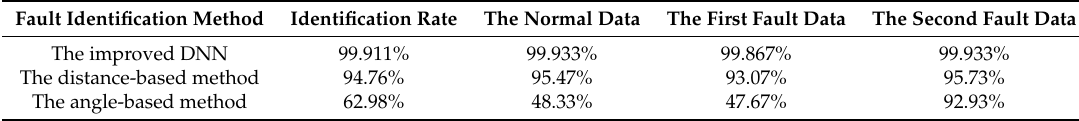
Table 4. The identification rates of various